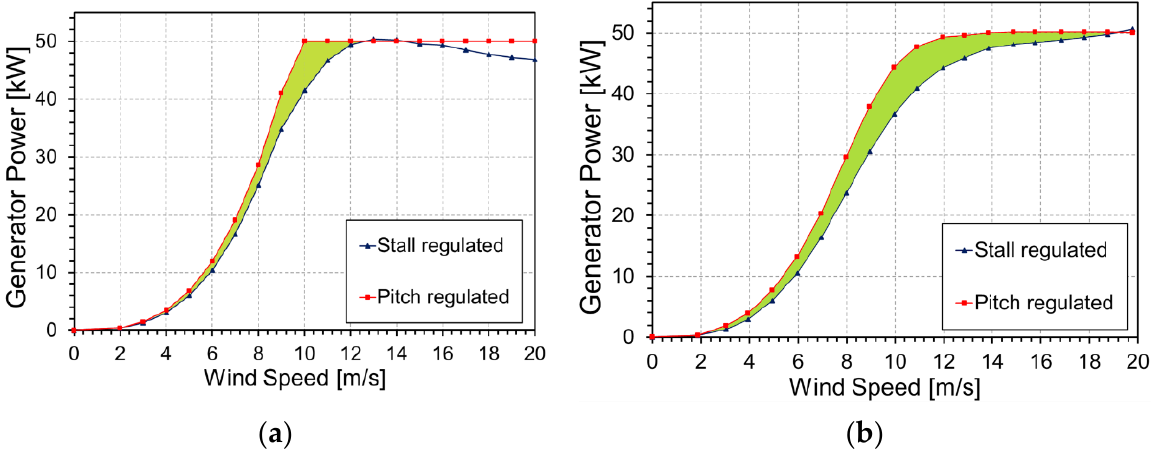
Figure 12. Power curves for the pitch- and stall-regulated turbines in steady conditions ( a ) and dynamic inflow conditions ( b ).